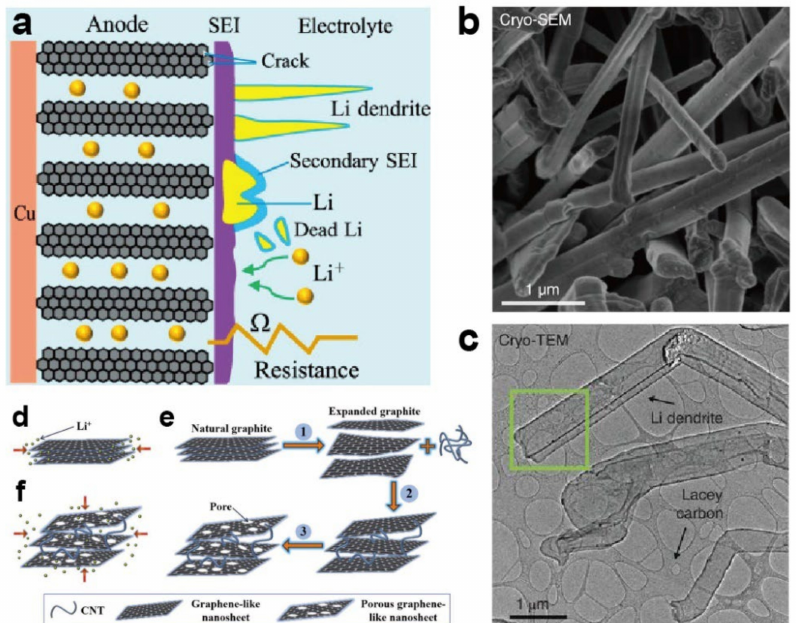
Figure 4. ( a ) Problems with graphite anode at low temperature [73]. Reproduced with permission from Journal of Power Sources; published by Elsevier, 2020; ( b , c ) Cryo-SEM image and Cryo-TEM image of Li dendrites [78]. Reproduced with permission from Science; published by American Association for the Advancement of Science, 2017; schematic diagram of Li ion intercalation process in ( d ) conventional graphite and ( e ) PGN; ( f ) synthesis of PGN/CNT material [79]. Reproduced with permission from Journal of Power Sources; published by Elsevier,